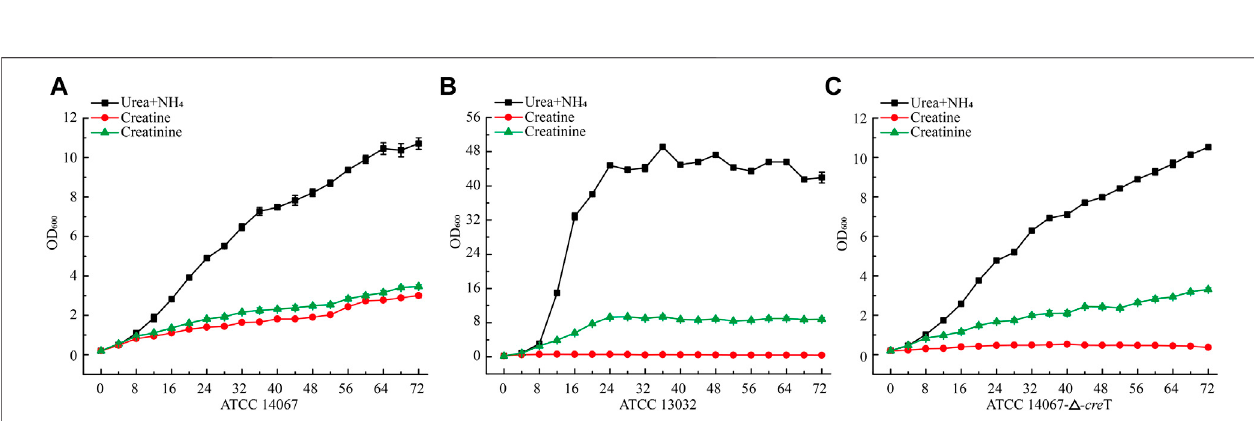
FIGURE 4 | Growth curve of C. glutamicum ATCC 14067 wild-type, the △ cre T, and C. glutamicum ATCC 13032 strains with a different nitrogen sources. (A) C. glutamicum ATCC14067growsinCGXIImediumwithammonium andurea,10 mMcreatineor10 mMcreatinineasnitrogensources. (B) C.glutamicum ATCC14067- △ cre T grows in CGXII medium with ammonium and urea, 10 mM creatine or 10 mM creatinine as nitrogen sources. (C) C. glutamicum ATCC 13032 grows in CGXII medium with ammonium and urea, 10 mM creatine or 10 mM creatinine as nitrogen sources.